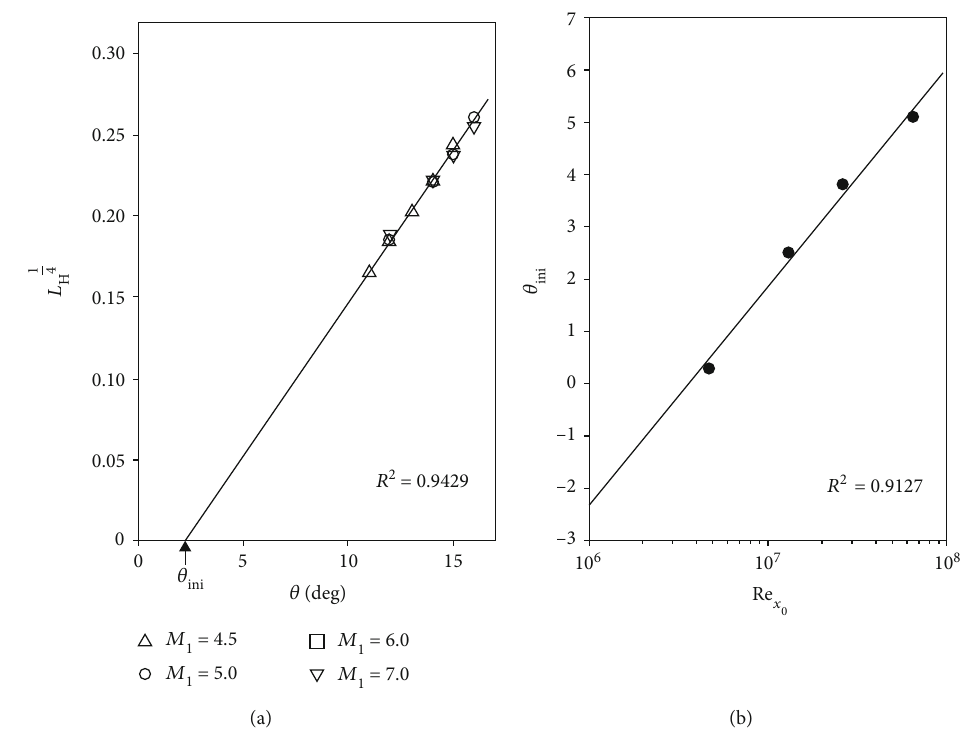
≤ 7 ): (a) in fl uence of the fl ow de fl ection angle on the separation length and (b) 1